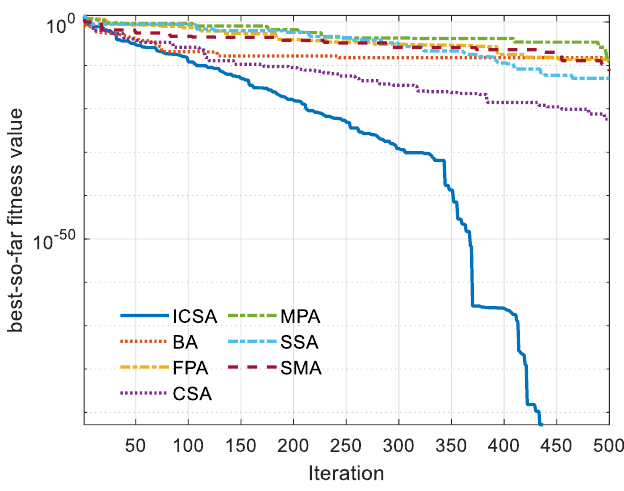
Figure 17. Convergence curve for F17.